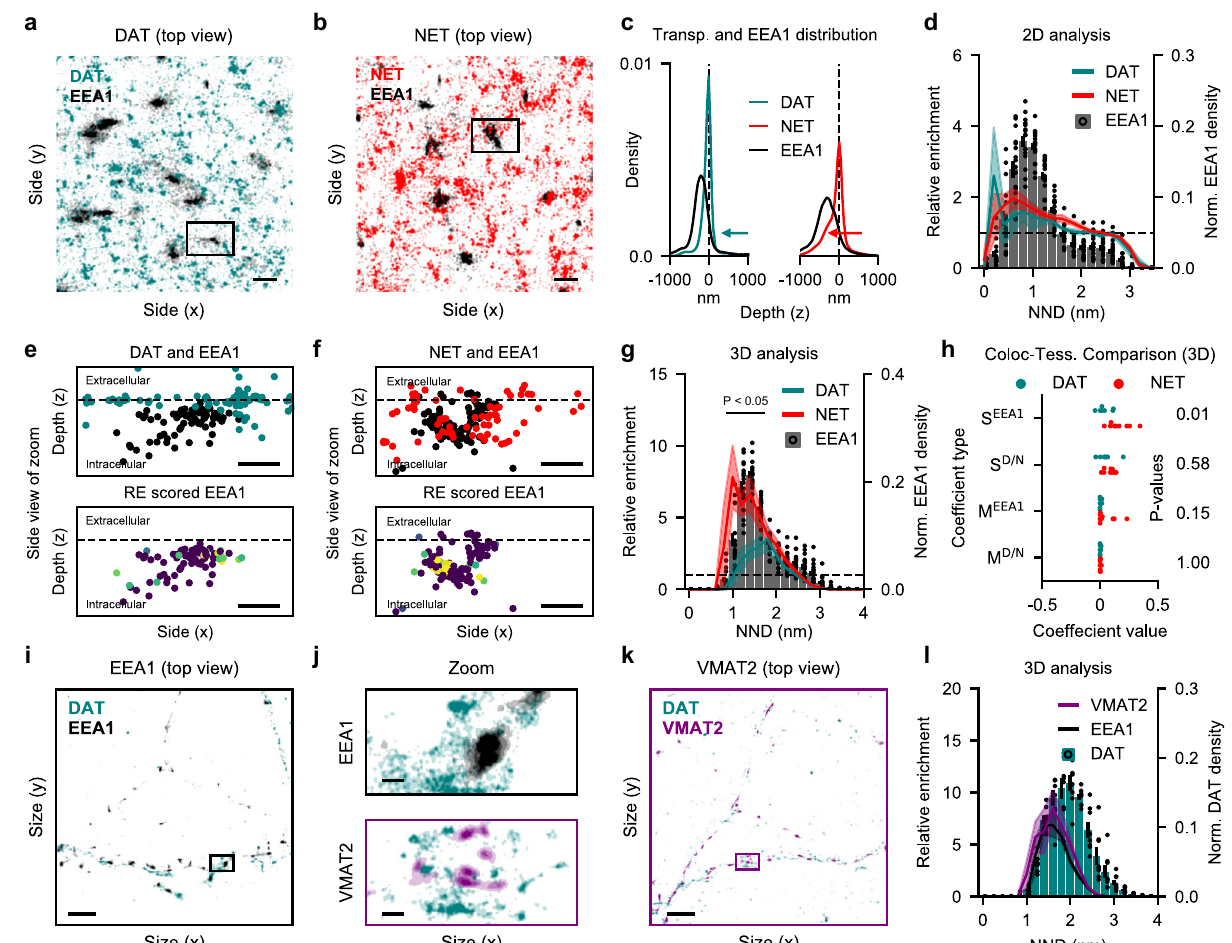
Fig. 5 | Neurotransmitter transporter localization to early endosomes. a Representative topview ofimage with EEA1 and DATin PC-12 cells acquired with astigmaticdSTORM.Molecularlocalizationsvisualizedbygaussianrepresentation. Scalebaris 0.5 µ m. b Representative topviewof image with EEA1and NET in PC-12 cells acquired with astigmatic dSTORM. Molecular localizations visualized by gaussianrepresentation.Scalebaris0.5 µ m. c Meandistributionoftransporterand EEA1-positive structure depth. Normalized to peak transporter depth. Arrows indicate the differential intracellular accumulation of NET. d EEA1 Voronoï regions binned by nearest neighbour distance in 2D, with mean RE value of each bin for both DAT ( n =7 images) and NET ( n =8 images) as dots. Error bars area indicates S.E.M.. e , f Side view of black box from ( a ) and ( b ). Top panel shows both species, and bottom panel EEA1 localization color-codedbyrelative enrichment (RE) score. Dashed lines indicate plasma membrane depth as assessed by median transporter location inz.Scale baris 200nm. g Same as( d )but assessedin 3D(H 0 :DAT=NET.